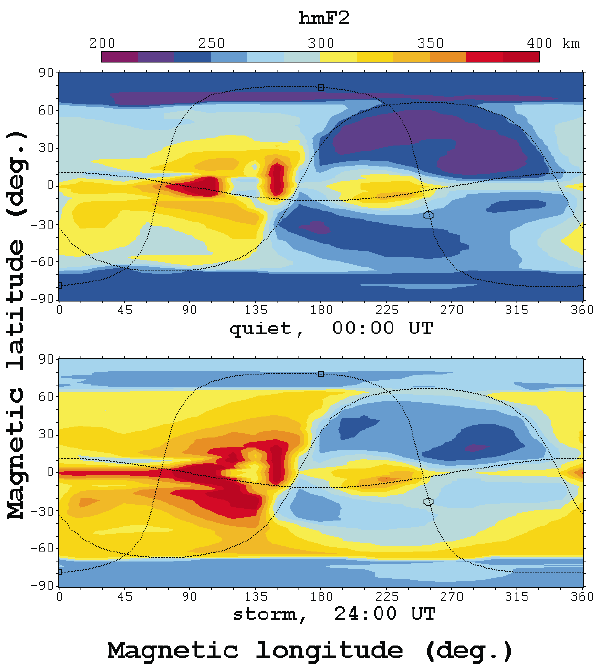
Fig. 6. Peak height of the F panel ) and disturbed ( lower panel ) conditions at the start and the end of the modelled day, respectively